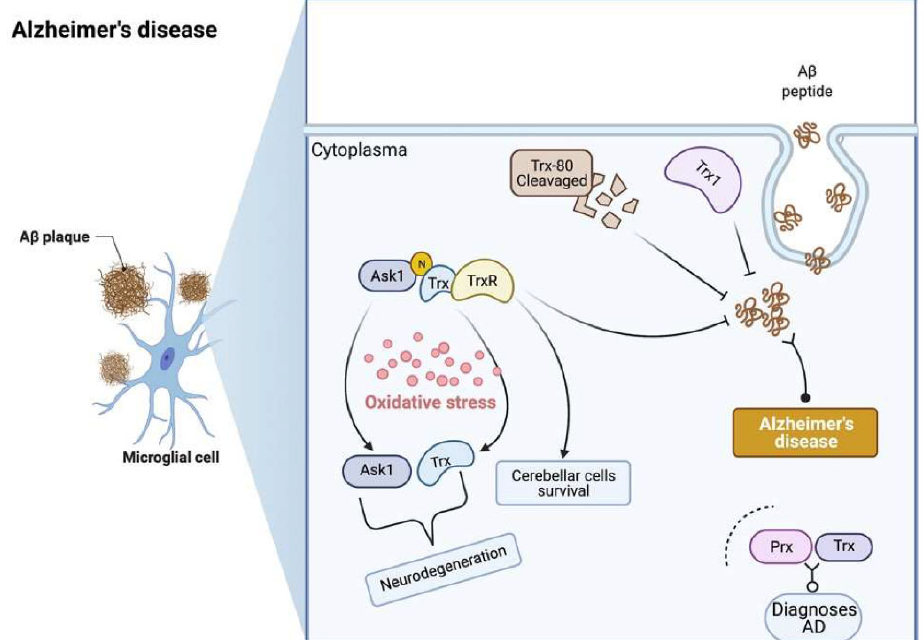
Figure 2. The role of the Trx system in the pathophysiology of Alzheimer’s disease (AD). The combination of Trx with ASK1 may play a role in the neurodegeneration and survival of cerebellar cells. The increased expression of TrxR, Trx1 and Trx80 decreases the accumulation of A β in AD patients. Prx and Trx can be used to diagnose AD in lab instead of clinical application. Trx: thioredoxin; TrxR: thioredoxin reductase; Prx: peroxiredoxin; ASK1: apoptosis signal-regulating kinase 1; A β : amyloid β .